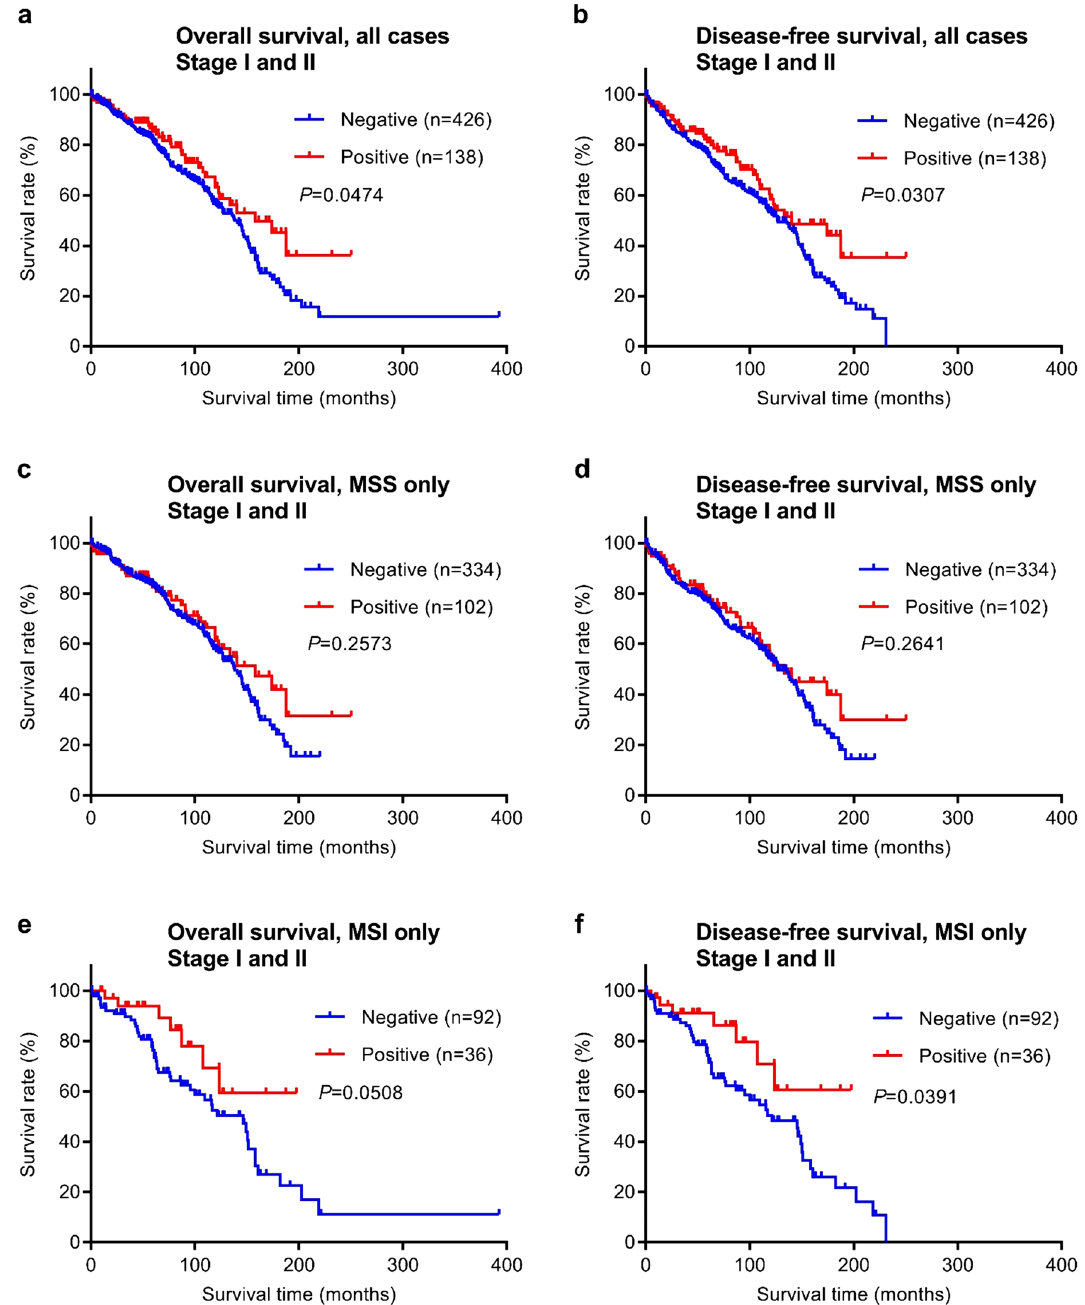
Figure 4. Overall survival and disease-free survival analysis of early stage (stages I and II) CRC stratified by DDX21 protein expression. ( a , b ) Kaplan–Meier curves with stratification by DDX21 protein expression for all cases (n = 564). ( c , d ) Kaplan–Meier curves for MSS CRC cases only (n = 436). ( e , f ) Kaplan–Meier curves for MSI CRC cases only (n =